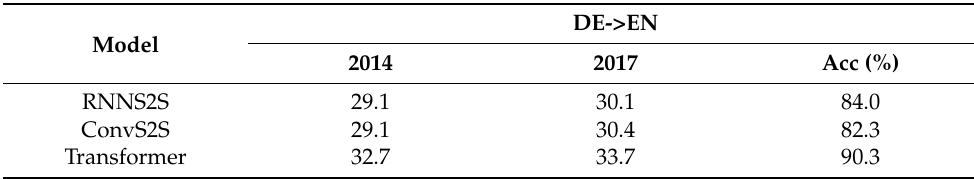
Table 2. Comprehensive feature extraction ability comparison of RNN/CNN/transformer [19]. 2014 and 2017 are the test set of NLP which can be found in the literature [19]; DE-EN: German to English; Acc means accuracy on the test set.